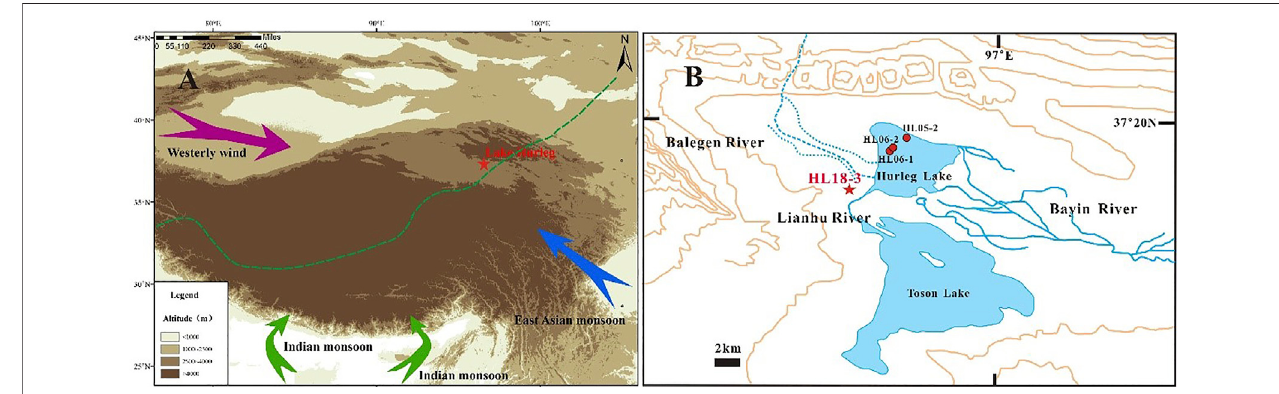
FIGURE 1 | Location of the study area. (A) Map showing the study site of Hurleg Lake (red pentagram); the purple, green, and blue arrows indicate westerly wind, Indian monsoon, and East Asian monsoon, respectively; the modern East Asian monsoon limit is shown by the green dashed line (after Gao, 1962; and Chen et al., 2008). (B) Core locations of HL18-3 (this study, red solid Pentagram), HL05-2, HL06-1, and HL06-2 (red solid circles) (Zhao et al.,